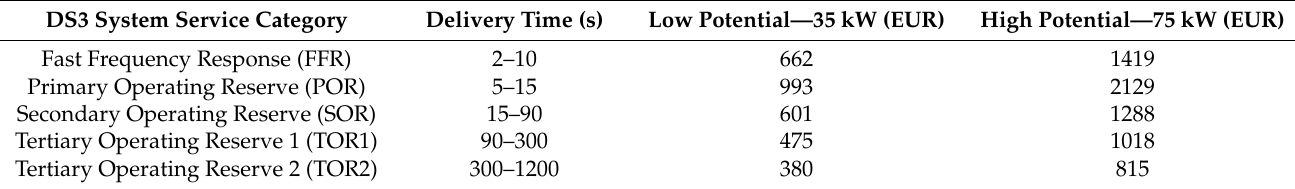
Table 9. Overview of annual payments achievable by a single site offering low potential and high potential capacities under five of the frequency response DS3 system services.